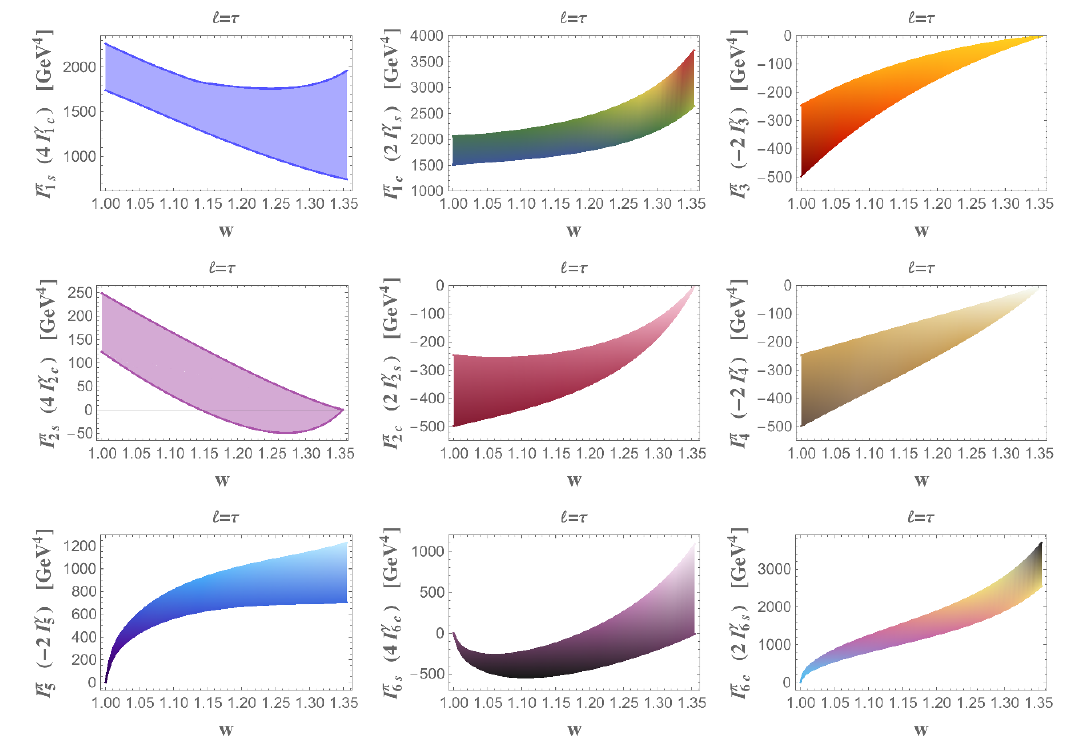
Figure 8 . Angular coe(cid:14)cients in the fully di(cid:11)erential decay distribution eq. (3.1) for ‘ = (cid:28) , with the tensor operator in the e(cid:11)ective Hamiltonian and coupling (cid:15) (cid:28) (cid:12)gure 6.